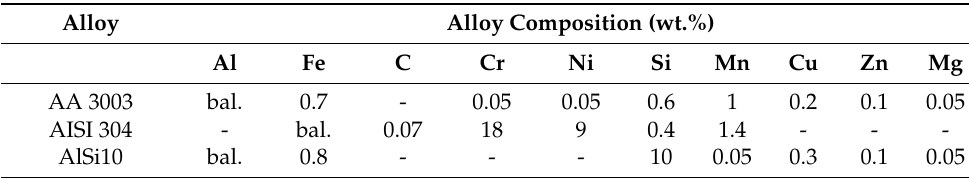
Table 1. Chemical composition of the used materials.